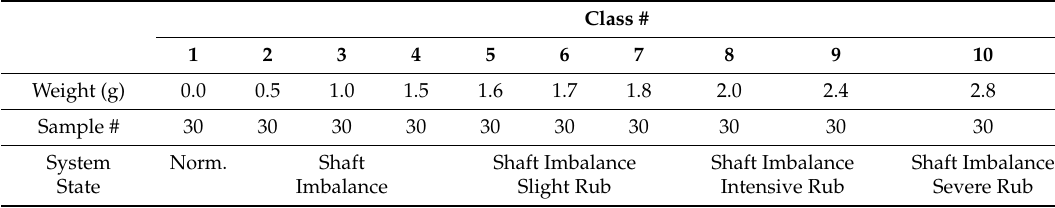
Table 1. The main properties of the collected signal